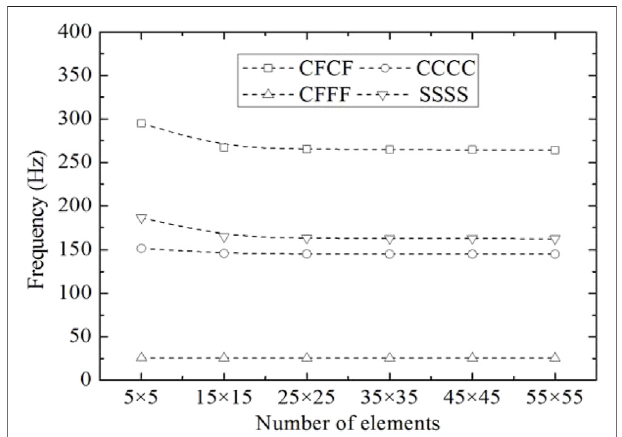
FIGURE 2 | Convergence study of the piezoelectric-integrated plate under different boundary conditions.